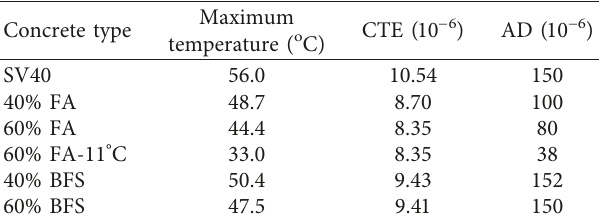
Table 5: Constant coefficient of thermal expansion (CTE) and autogenous deformation (AD) after 12